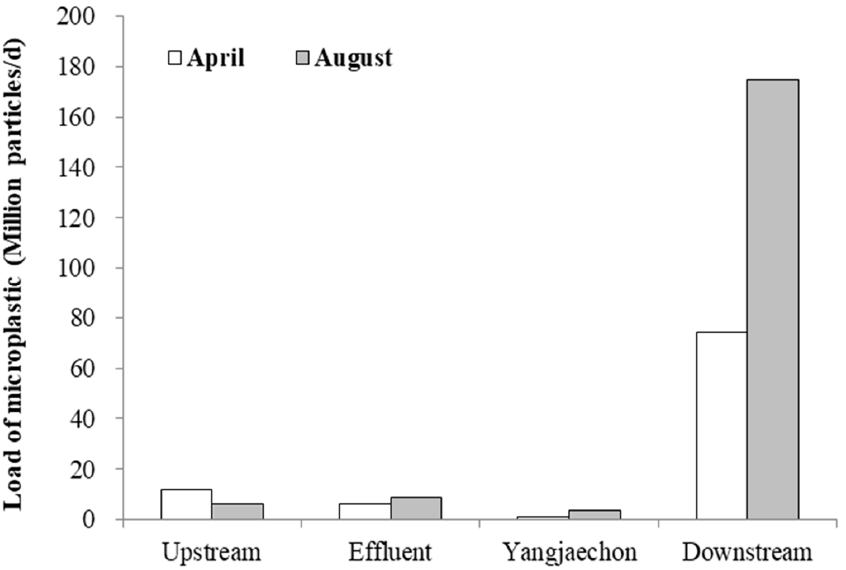
Figure 3. Daily load of microplastics (the concentration of microplastics times the flow rate) from upstream, sewage treatment plant effluent, Yangjaechon creek, and downstream in Tanchon stream.